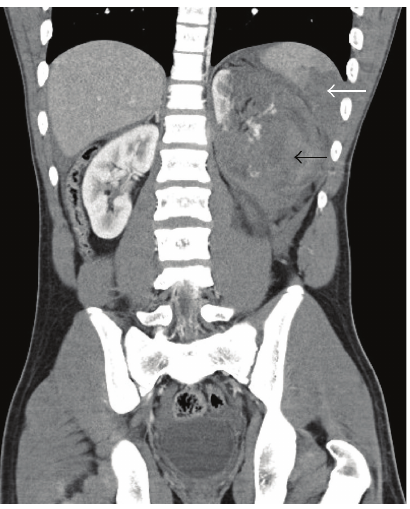
Figure 2: Coronal reconstruction revealing extensive left renal (black arrow) and splenic injuries (white